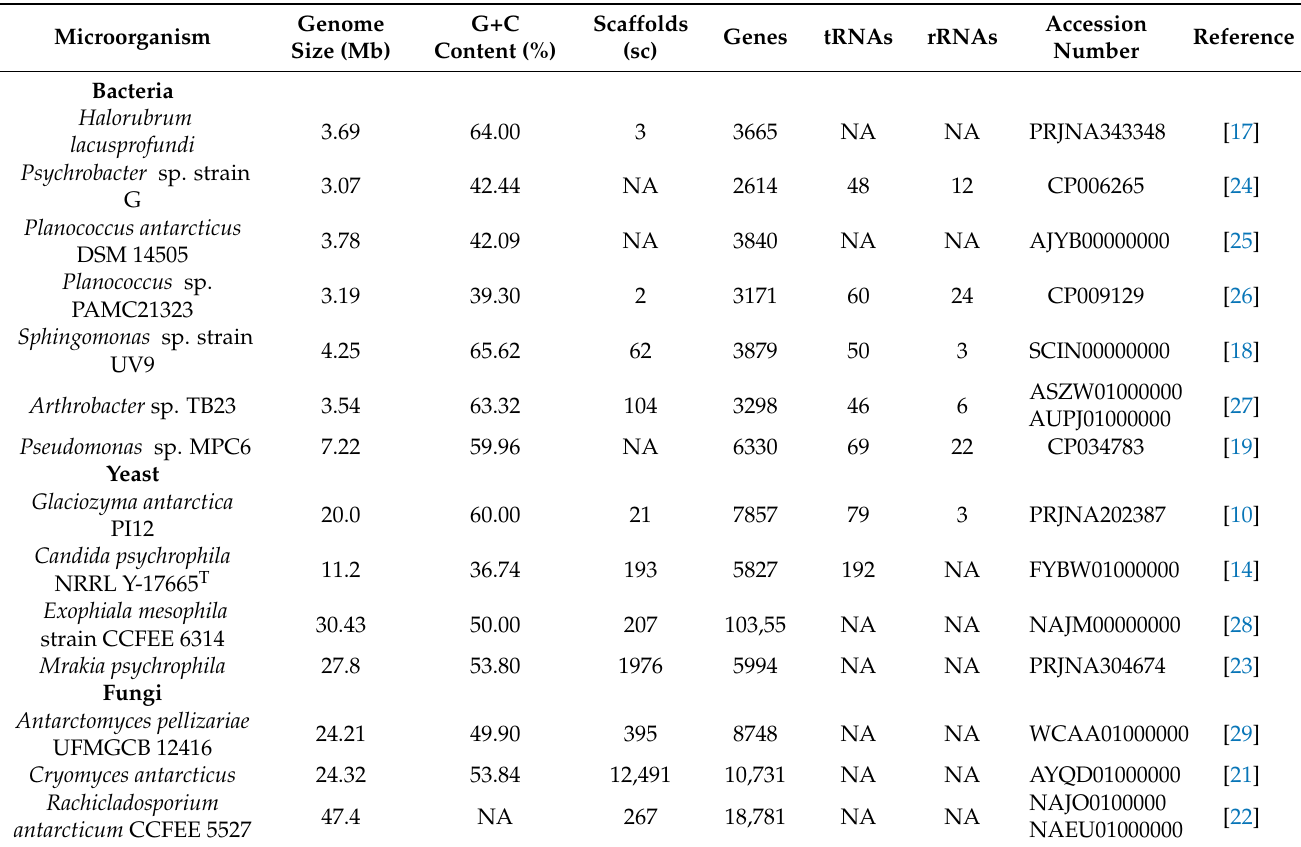
Table 1. Summary of the G . antarctica genome in comparison to the genomes of other psychrophilic bacteria, yeast and